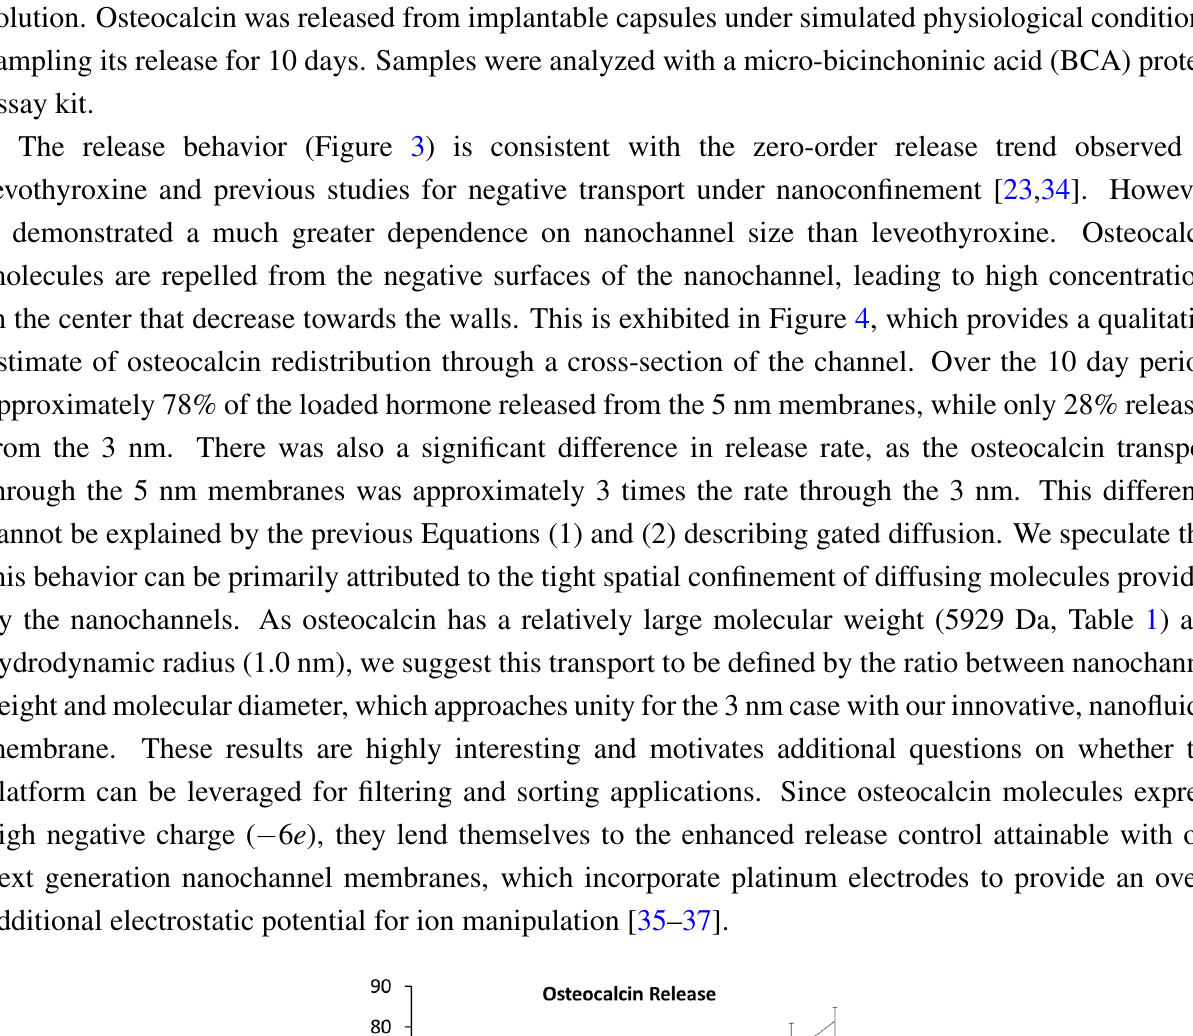
Figure 4. Cross-section of a nanochannel qualitatively showing the distribution of a 5 nm nanochannel. Please note that the aspect ratio was lessened for better visual representation of the molecular distribution.